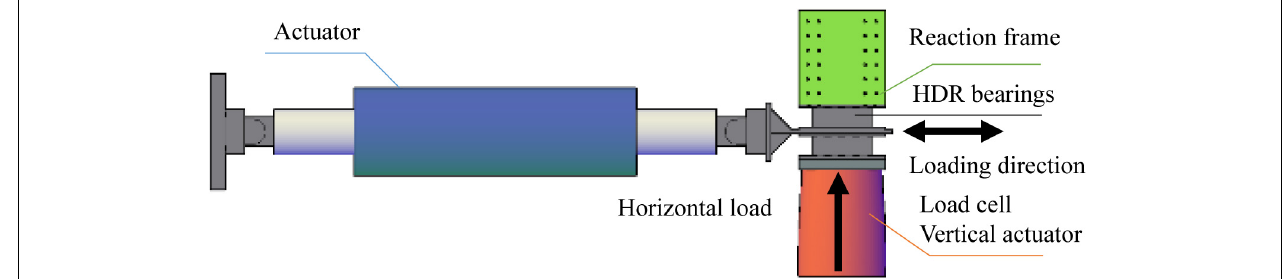
FIGURE 6 | Hybrid simulation test setup for HDR bearings.